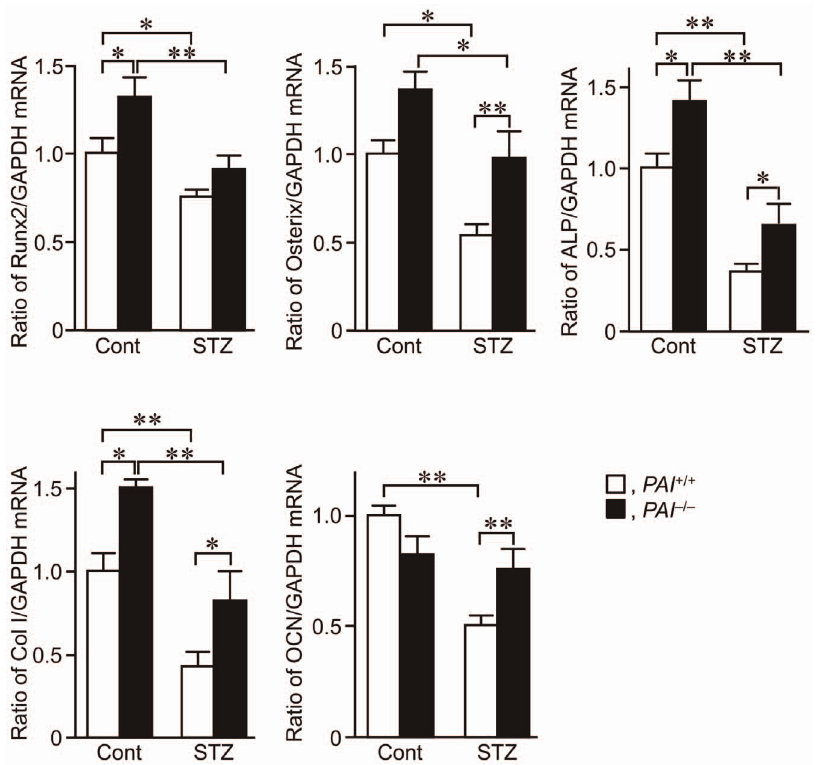
Figure 4. Effects of PAI-1 deficiency on osteogenic differentiation during bone repair in female mice. The levels of Runx2, Osterix, ALP, type I collagen (Col I), and osteocalcin (OCN) mRNA at the damaged site on day 7 after a femoral bone defect in female PAI-1 + / + and PAI-1 2 / 2 mice with or without STZ treatment. Data are expressed relative to GAPDH mRNA values, and are expressed as the mean 6 SEM. * p , 0.05, ** p , 0.01 (n=5– 7 in each group). Cont,